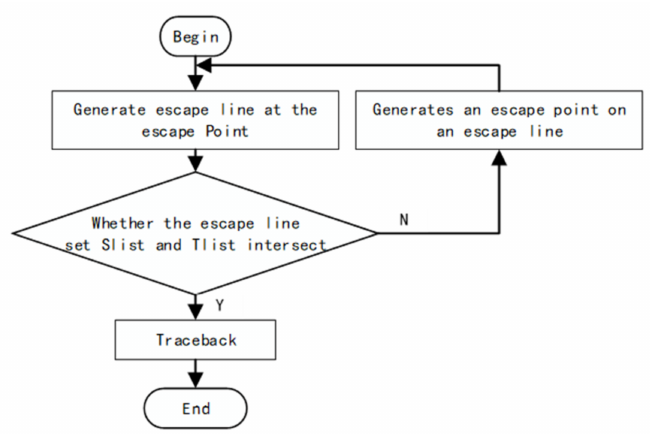
Figure 1. Design process of line exploration